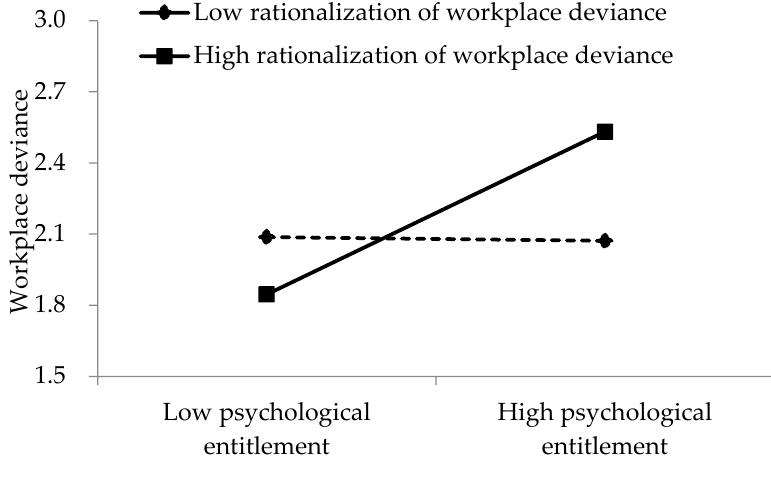
Figure 2. The moderating role of rationalization of workplace deviance.